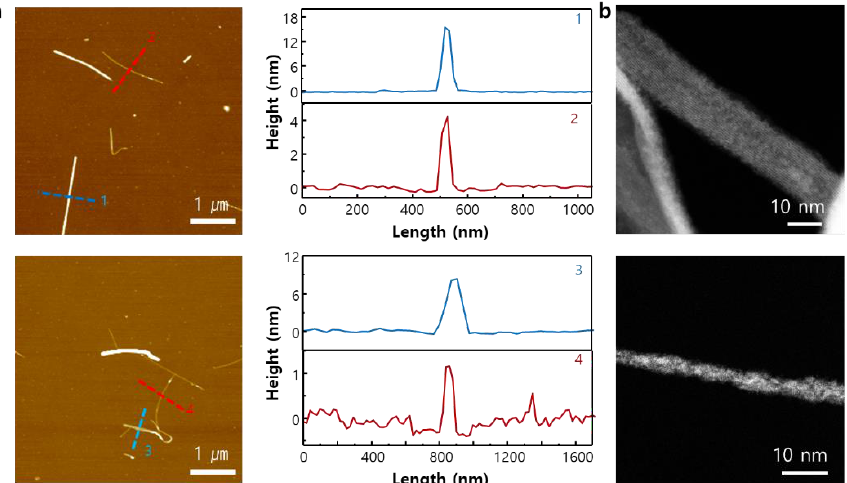
Figure 4. ( a ) Atomic force microscopy (AFM) image of the exfoliated Nb 2 Se 9 nanowires on Si/SiO 2 wafers; the height profiles are shown along each dashed line; ( b ) Annular dark-field (ADF)-STEM image of the exfoliated Nb 2 Se 9 nanowires.